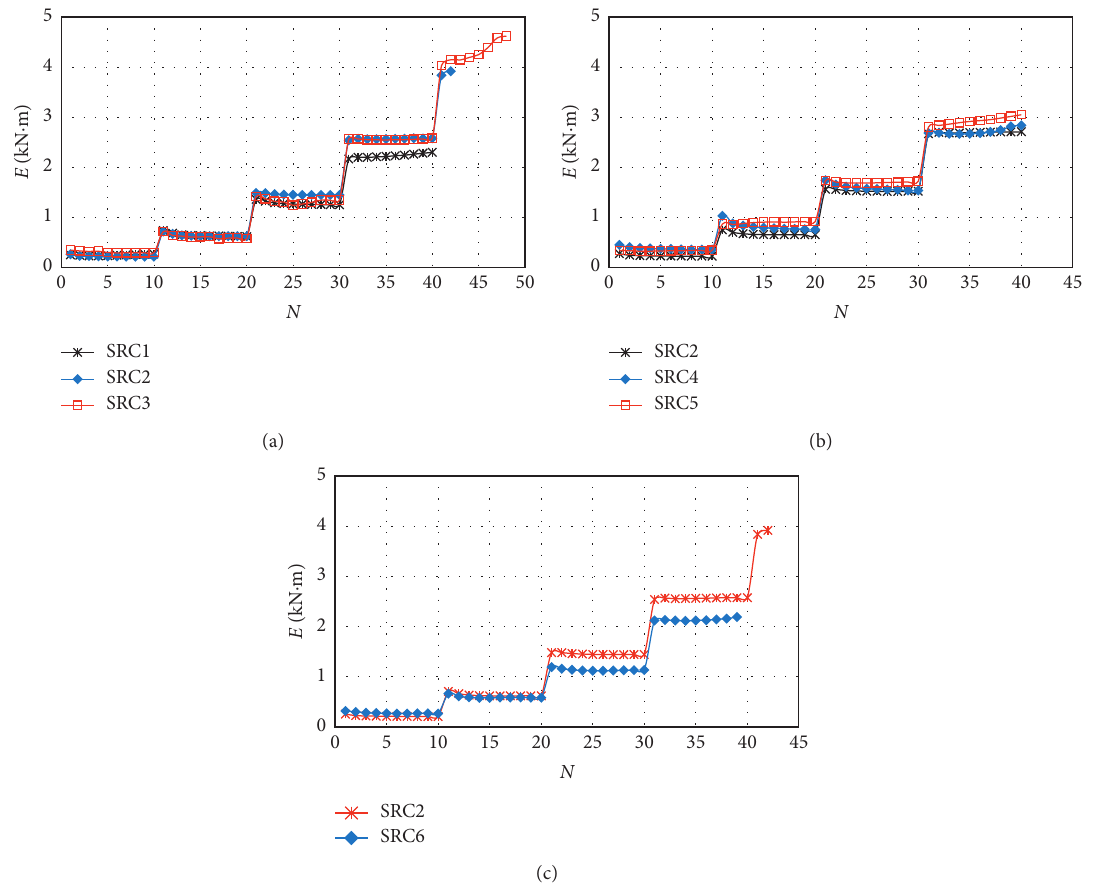
Figure 8: Relation curves between hysteresis energy-cycle loading number E - N of specimens. Effect of (a) steel ratio on E , (b) stirrup ratio on E , and (c) axial compression ratio on E